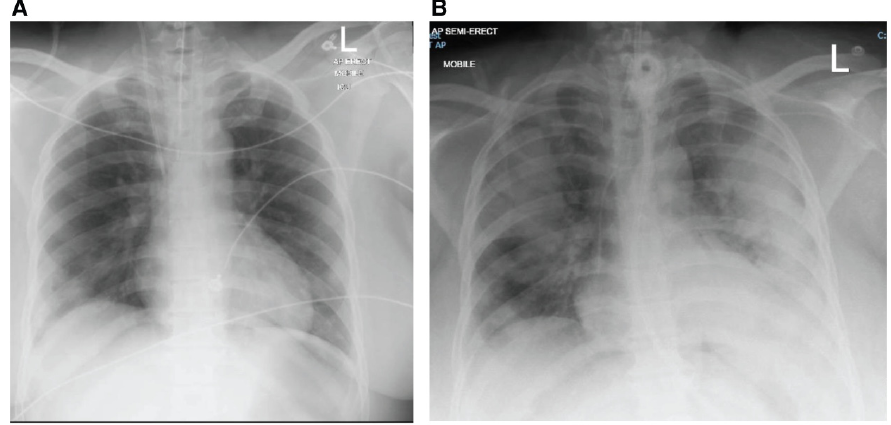
Figure 3. Case 2 radiographs. ( A ) Post-intubation plain chest radiograph, on day 1 of hospital admission. ( B ) Day 5 following re-intubation.